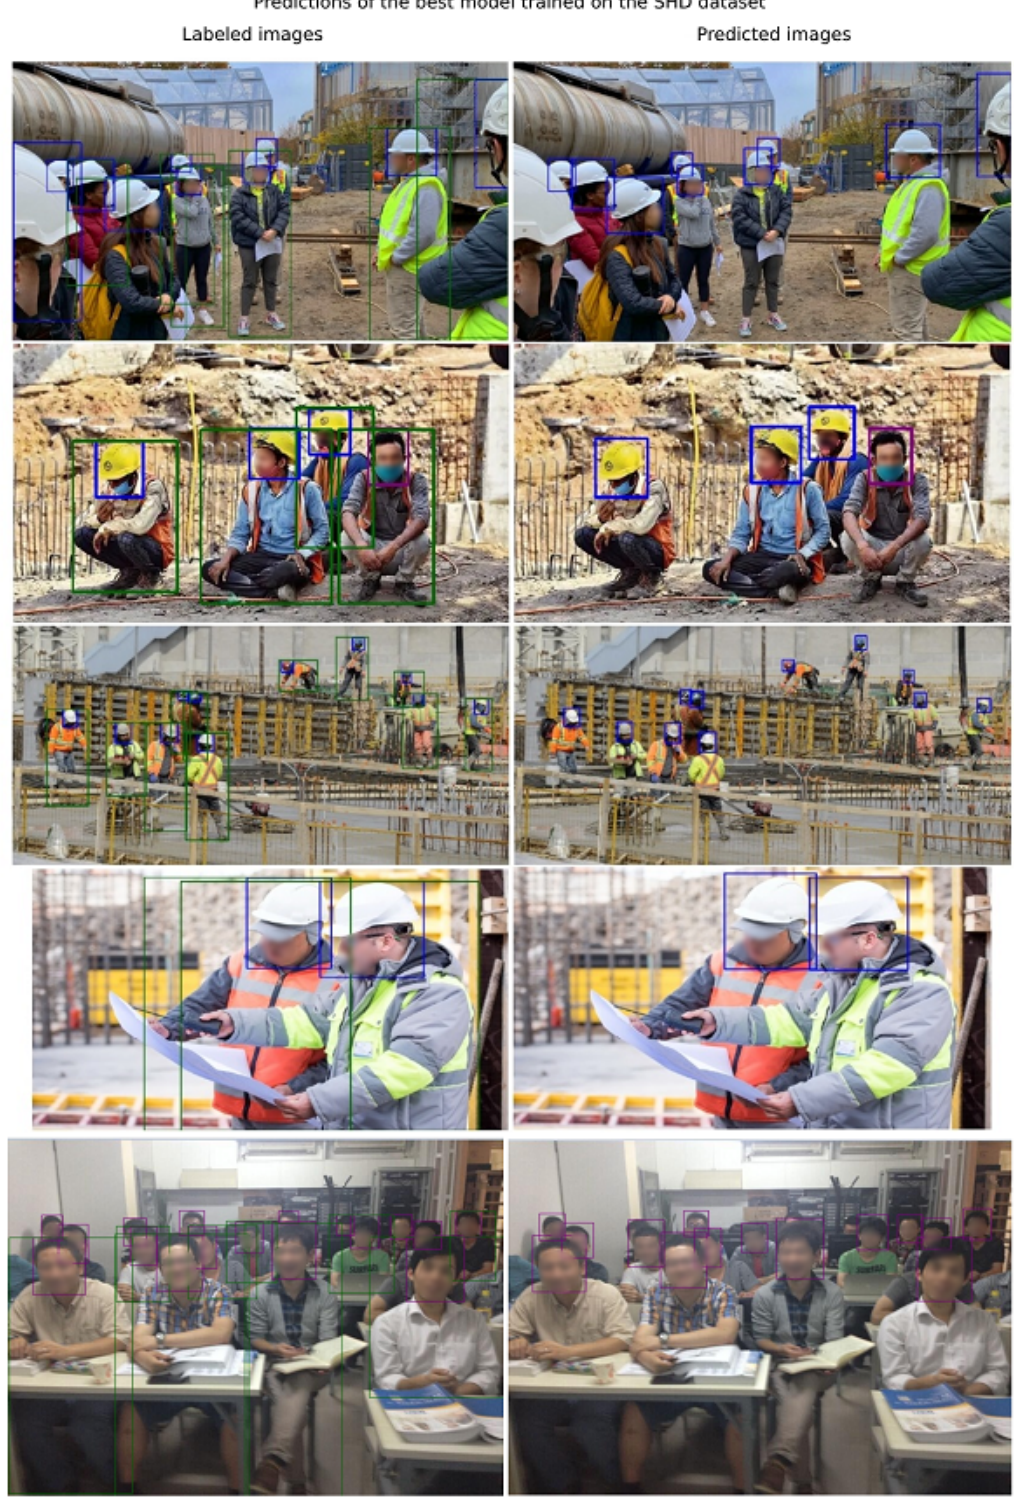
Figure A4. Predictions of the best model trained on the SHD dataset [8] and the ground truth labels of the sample